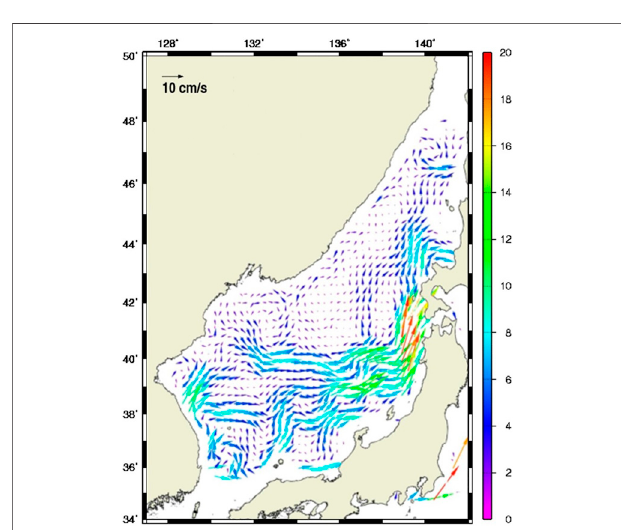
FIGURE10| SpatialdistributionofgeostrophiccurrentsfromthenewOI in February.